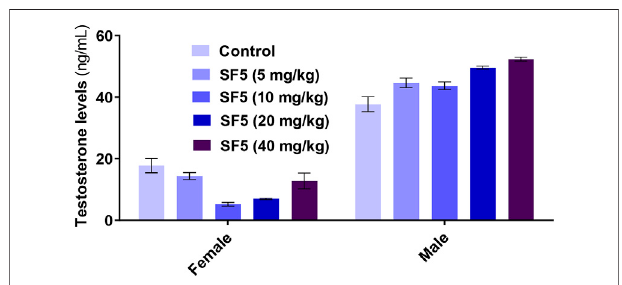
FIGURE 13 | Effect of repeated-dose administration of a different dose of SF5 on testosterone levels in the serum of the treated animals in the subacutetoxicitystudy.Dataarepresentedasmean ± SEM, n (cid:1) 3,*** p < 0.01 compared to the